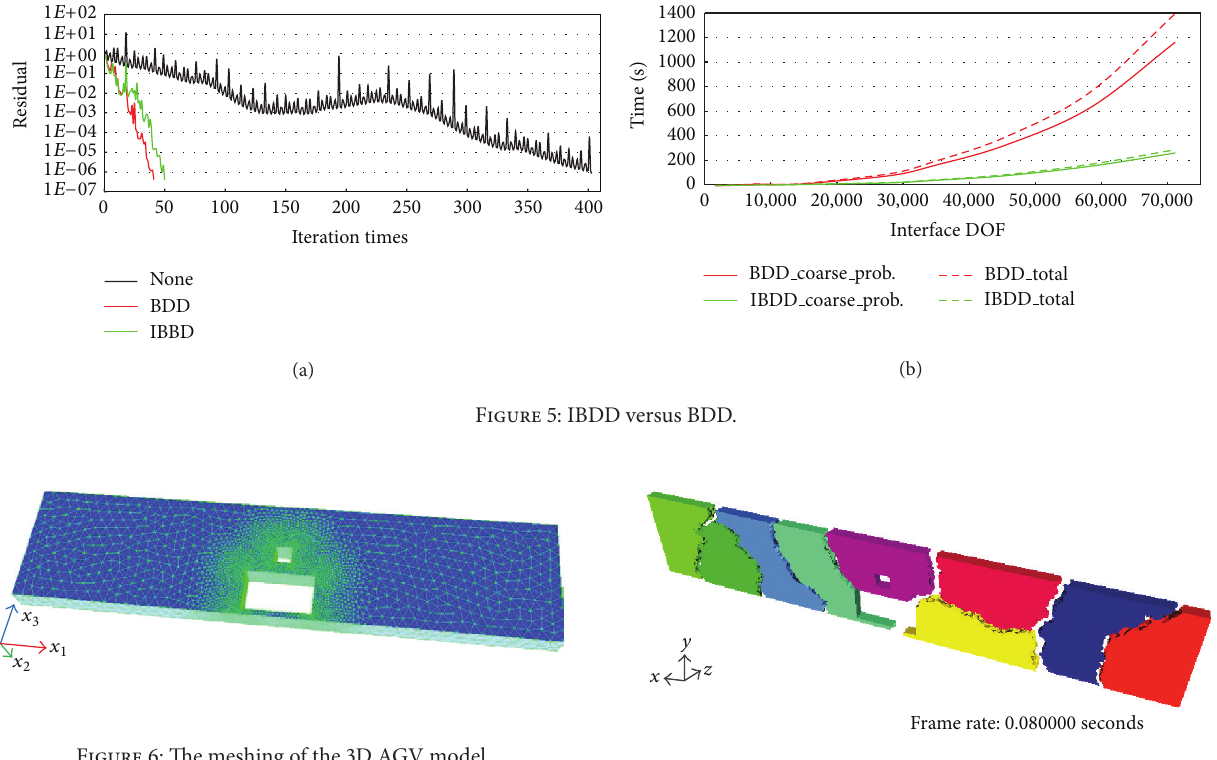
Figure 6: The meshing of the 3D AGV model.